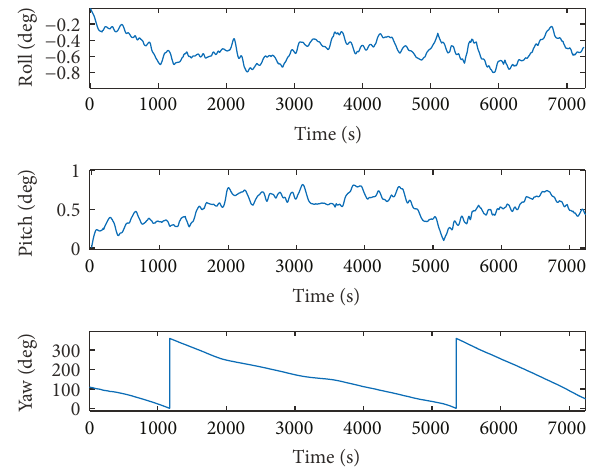
Figure 3: Attitude pro fi le used in this work. This fi gure has been reproduced from the conference paper version of this work